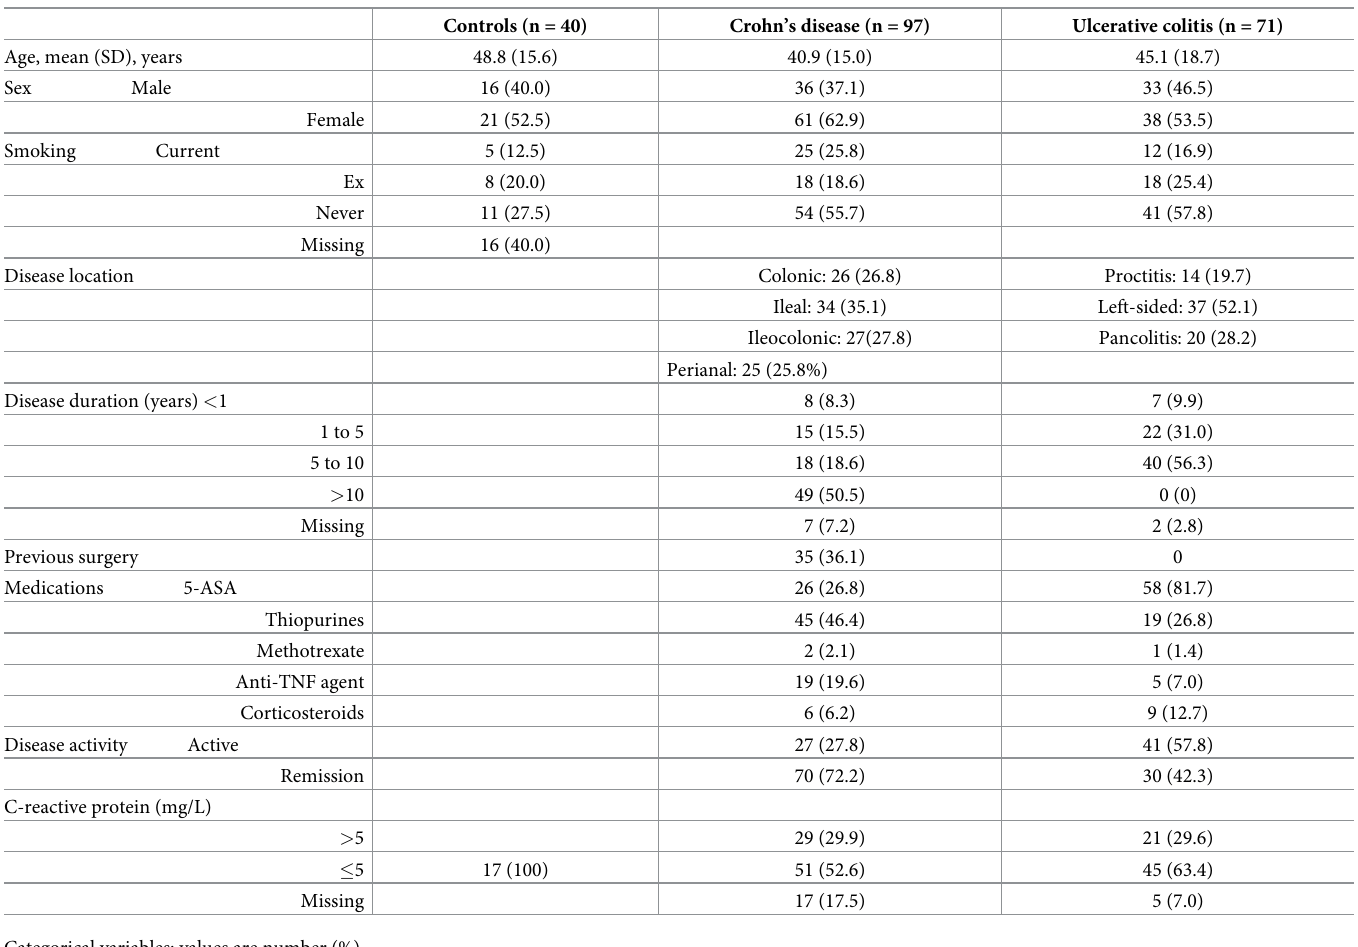
Table 1. Baseline characteristics of the IBD patients and control healthy